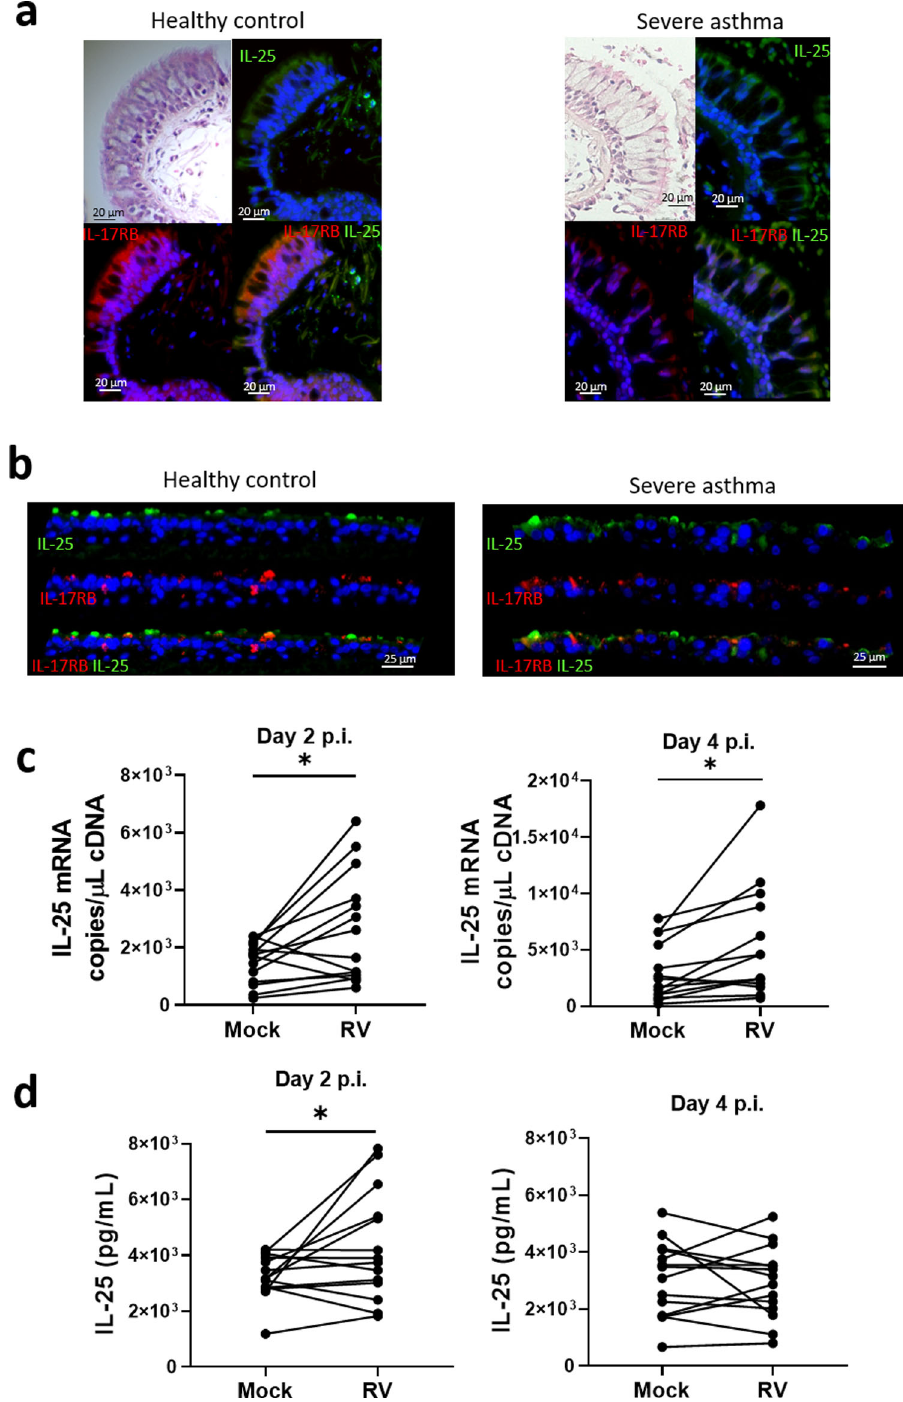
Fig. 1 Localization and production of IL-25 in bronchial epithelial cells. H&E and immuno fl uorescence staining of IL-25 and IL-17RB in ( a ) endoscopic bronchial biopsies or ( b ) air-liquid interface-differentiated bronchial epithelial cells (BECs) from healthy donors and donors with asthma. IL-25 ( c ) mRNA and ( d ) cell-associated protein from RV-A1 infected BECs from donors with asthma at 2- and 4-days postinfection. Representative of n = 5 endoscopic bronchial biopsies and BEC cultures, n = 14 RV-infected BECs, data analysed by Wilcoxon matched pairs test * p < 0.05. Scale bars represent 20 μ m and 25 μ m, respectively, as